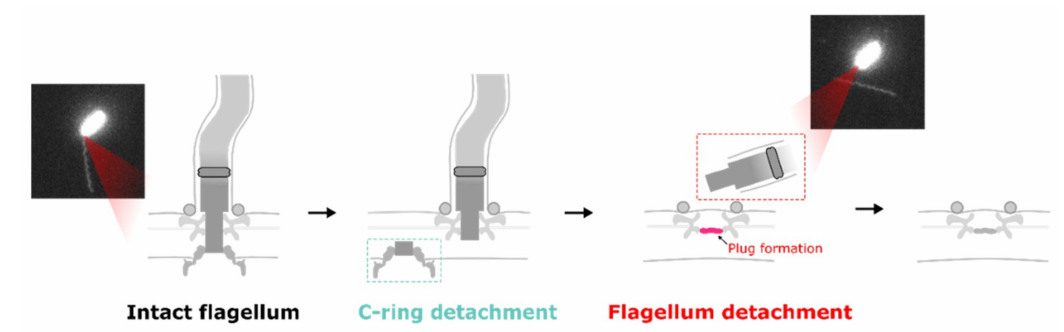
Figure 5. A model summarizing the disassembly process of a V. alginolyticus flagellum, showing that it begins with breaking the rod above the MS ring before FliG depolymerization. The C ring, with inner membrane components, then mobilizes on the cell membrane. Finally, the LP ring is likely sealed and the flagellum is